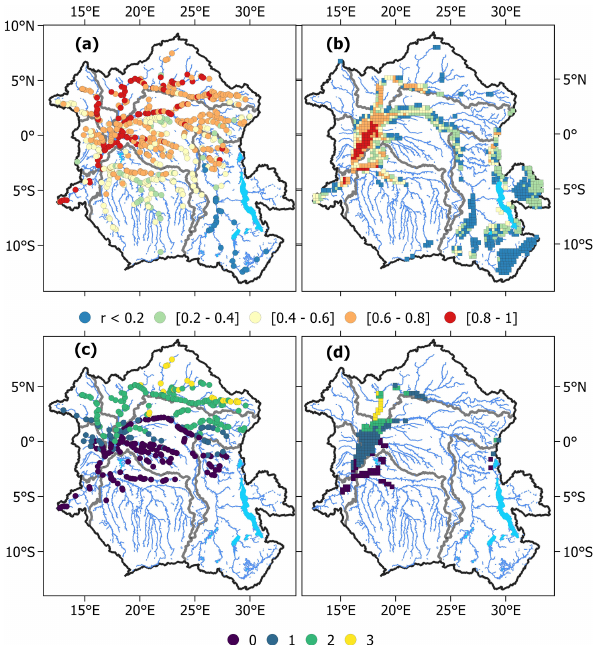
Figure 11. Maps of the optimal coefficient correlation and associ- ated lag at each VS and GIEMS-2 cell. (a) Optimum coefficient cor- relation between altimetry-derived SWH (from ERS2, ENV, SRL, J2/3, and S3A missions) at each VS against the in situ water stage at the Brazzaville/Kinshasa station. (b) Same as (a) for each GIEMS-2 cell against the river discharge at the Brazzaville/Kinshasa station. Panels (c) and (d) show, respectively, their optimum lag in months. In panels (c) and (d) , only the time lags for which the maximum correlation has a p value < 0.05 are